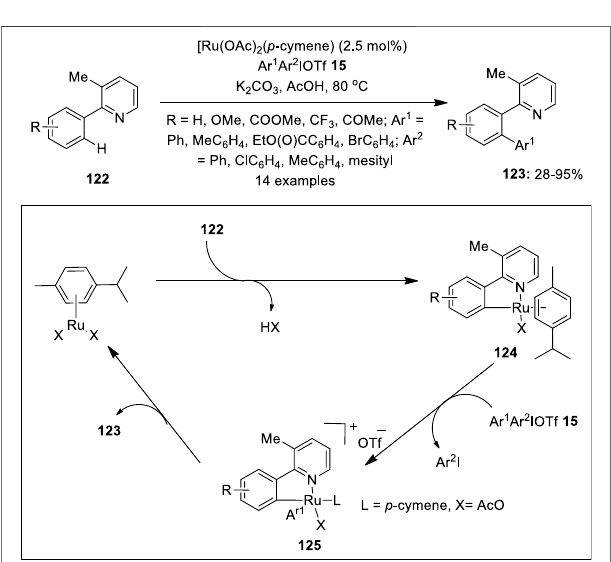
FIGURE 24 | Ru 2+ -catalyzed arylation of 2-arylpyridines 122 with Ar 1 Ar 2 IOTf 15 as an arylation reagent.